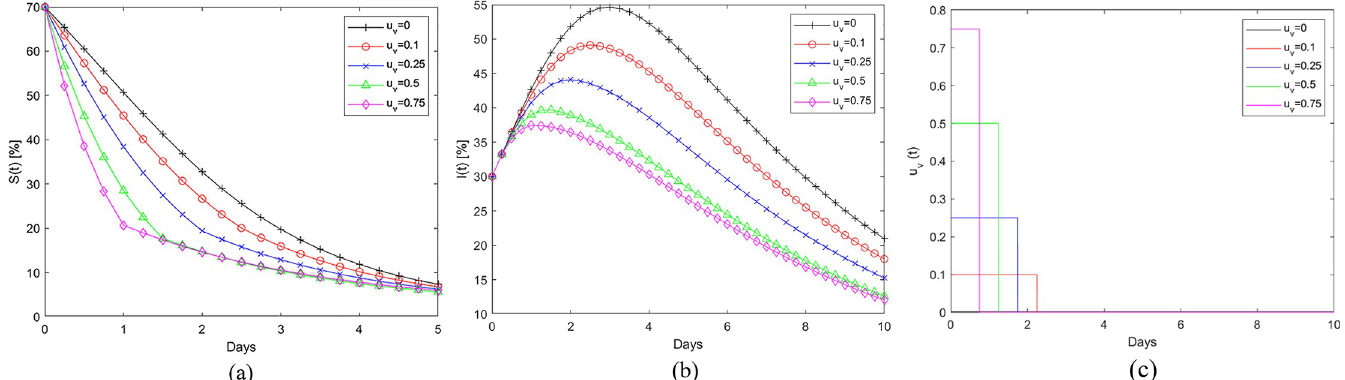
Fig 6. (a) Evolution of susceptible (operational) gas stations and the effect of refueling for Fort-Myers-Naples during Hurricane Irma. (b) Corresponding evolution of Infected or empty fuel stations. (c) The optimal application and switching time, t s , for different refueling rates.